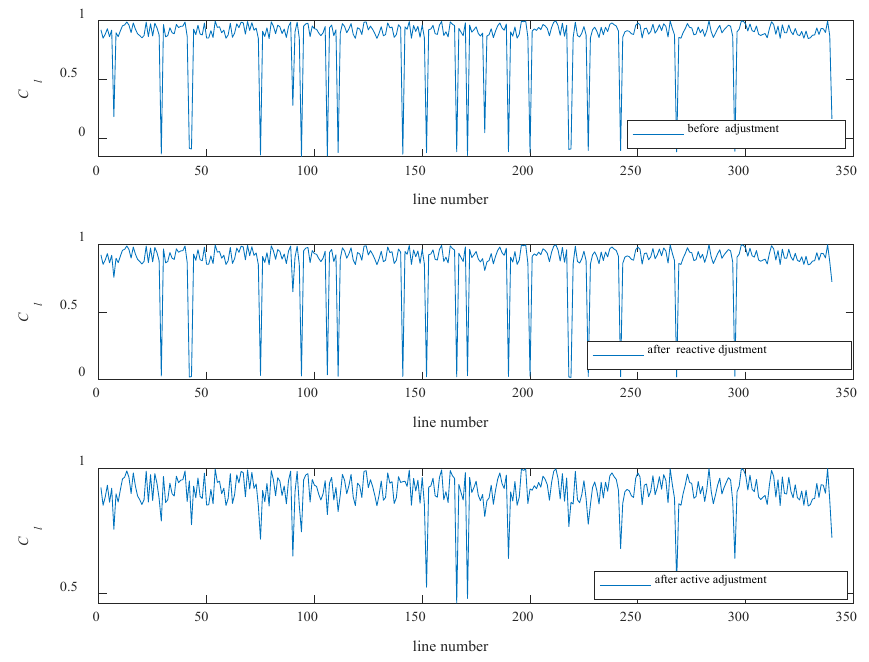
Figure 8. Line transmission metric before and after adjustment in Case 1.